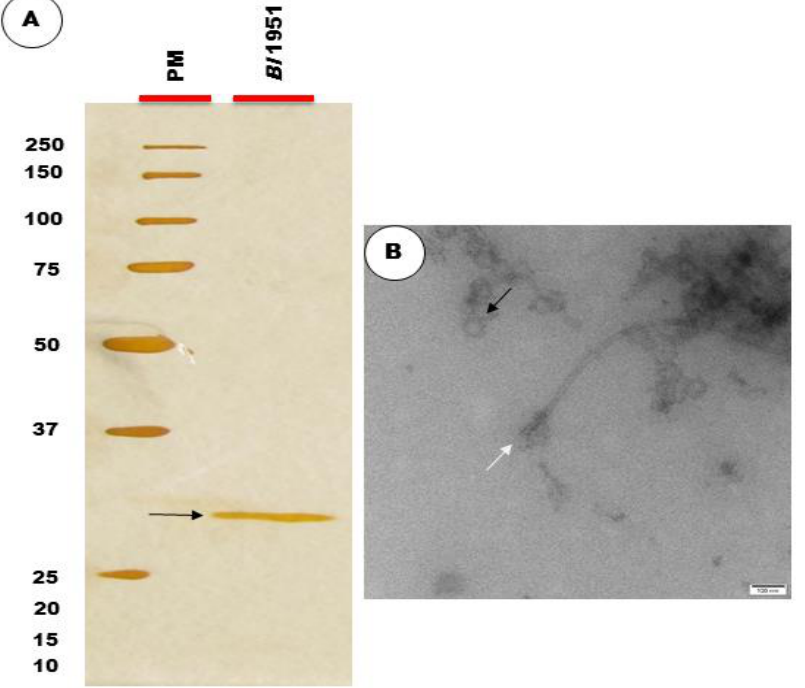
Figure 6. SDS-PAGE and TEM analysis of Bl 1951 purified and 10 kD MWCO membrane concen- trated putative antibacterial protein. SDS-PAGE analysis of Bl 1951 putative antibacterial protein showing a ~30 kD purified protein band (( A ), denoted with a dark arrow). Electron micrographs of a ~30 kD purified putative antibacterial protein of Bl 1951 showing globular or phage capsid-like (( B ), denoted with a dark arrow) and polysheath-like structure (( B ), denoted with a white arrow). Scale bar = 100 nm. PM denotes protein marker. 3.3. Purification of Putative Antibacterial Proteins of Bl 1821L Using Precipitation Methods PEG 8000 (10%)-precipitated putative antibacterial proteins of Bl 1821L upon further purification with group B sucrose density gradients showed protein bands of ~30 and ~48 kD. SDS-PAGE of the PEG 8000 (10%) lysate exhibited a very minor band of ~48 kD in 40% and 60% gradients protein when compared to those of ~30 kD (Figure S9). SDS PAGE of Bl 1821L ammonium-sulphate (85%)-precipitated culture with group B sucrose density gradients revealed a ~50 kD protein band from 50% and 60% gradients (Figure S10). 4. Discussion Protein purification is an intrinsic step to understand the nature of a targeted protein [17]. Therefore, various methods, such as SEC, sucrose density gradient centrifugation, PEG precipitation, and ammonium sulphate precipitation were undertaken to purify the putative antibacterial proteins of insect pathogenic isolates Bl 1821L and Bl 1951. Two pu- tative antibacterial proteins (~30 and ~48 kD) of Bl 1821L and one ~30 kD of Bl 1951 were purified. Electron micrographs of purified proteins showed different phage structural components similar to that seen in defective phages. Furthermore, SDS-PAGE of the pu- rified products of uninduced cultures (without mitomycin C) also showed the same pro- tein bands as mitomycin C-induced cultures. Through assessment of Bl 1951 SEC frac- tions, a population of transient resistant cells (persisters) in the Bl 1821L isolate was noted. Bacteria predominantly harbour prophages in their chromosomes either in true or defective lysogenic forms [11,41] that can be induced by DNA-damaging agents such as UV radiation or mitomycin C [42,43]. The induction is suicidal for the cells as it results in bacterial cell lysis [44,45] which extracellularly releases numerous proteins apart from